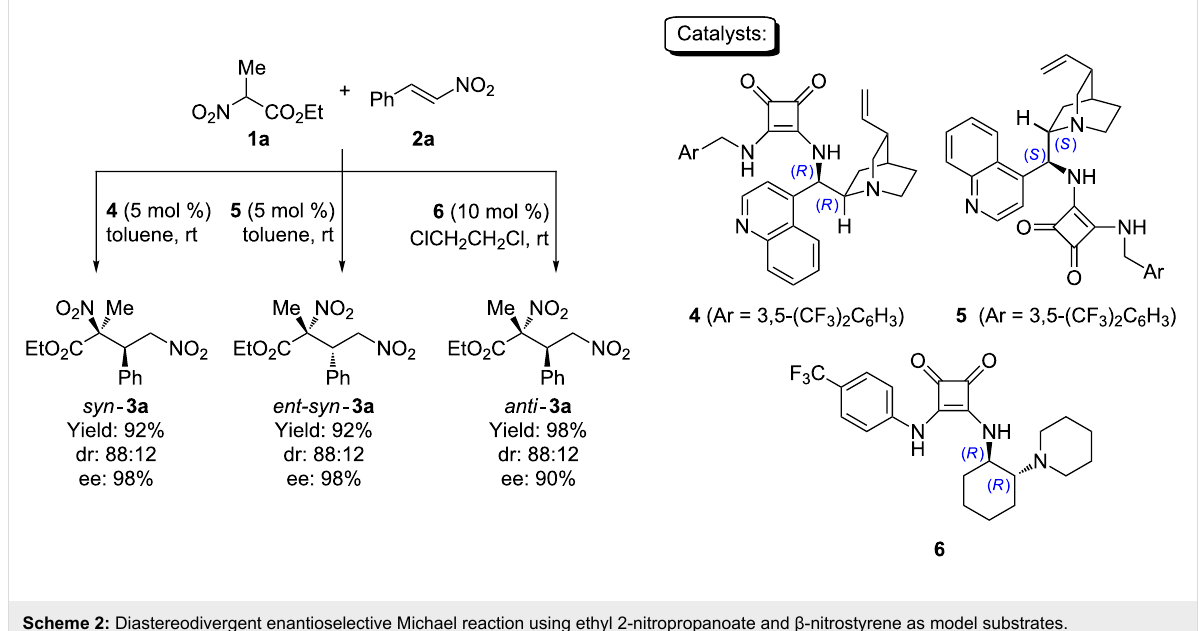
Table 1: Enantio- and diastereoselective Michael reaction between nitroesters 1 and nitroalkenes 2 catalysed by 4 . a